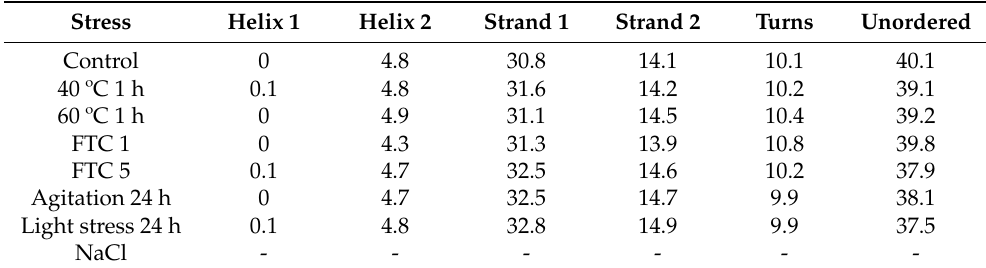
Table 2. Percentage estimation of the different secondary structures by Dichroweb from the Far UV CD